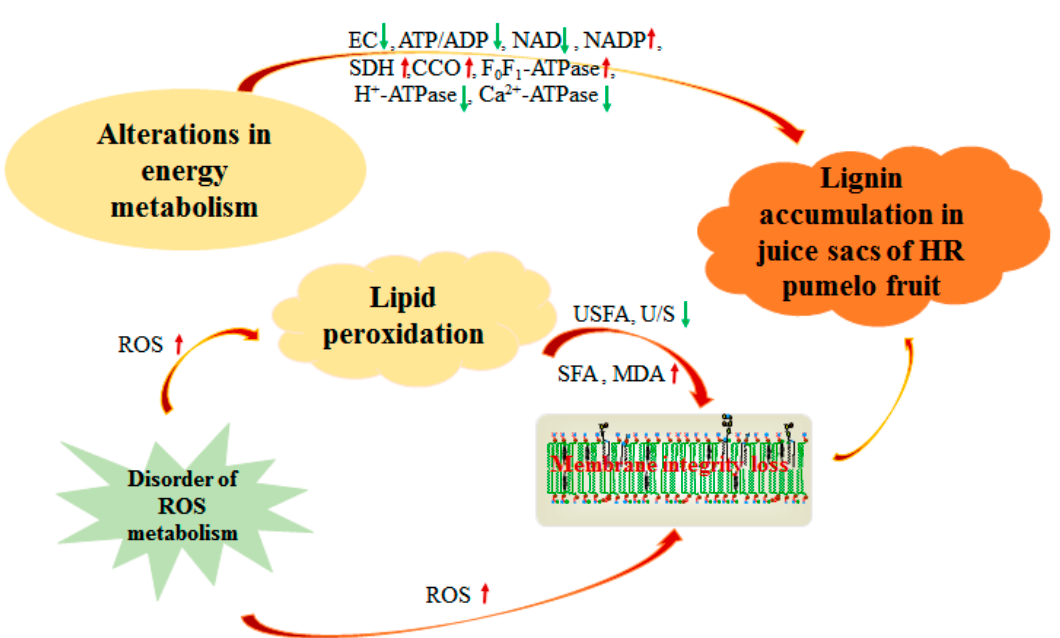
Figure 8. The probable mechanism of lignin accumulation affected by alterations in energy metabolism and membrane lipid metabolism in juice sacs of postharvest HR pumelos during storage period.